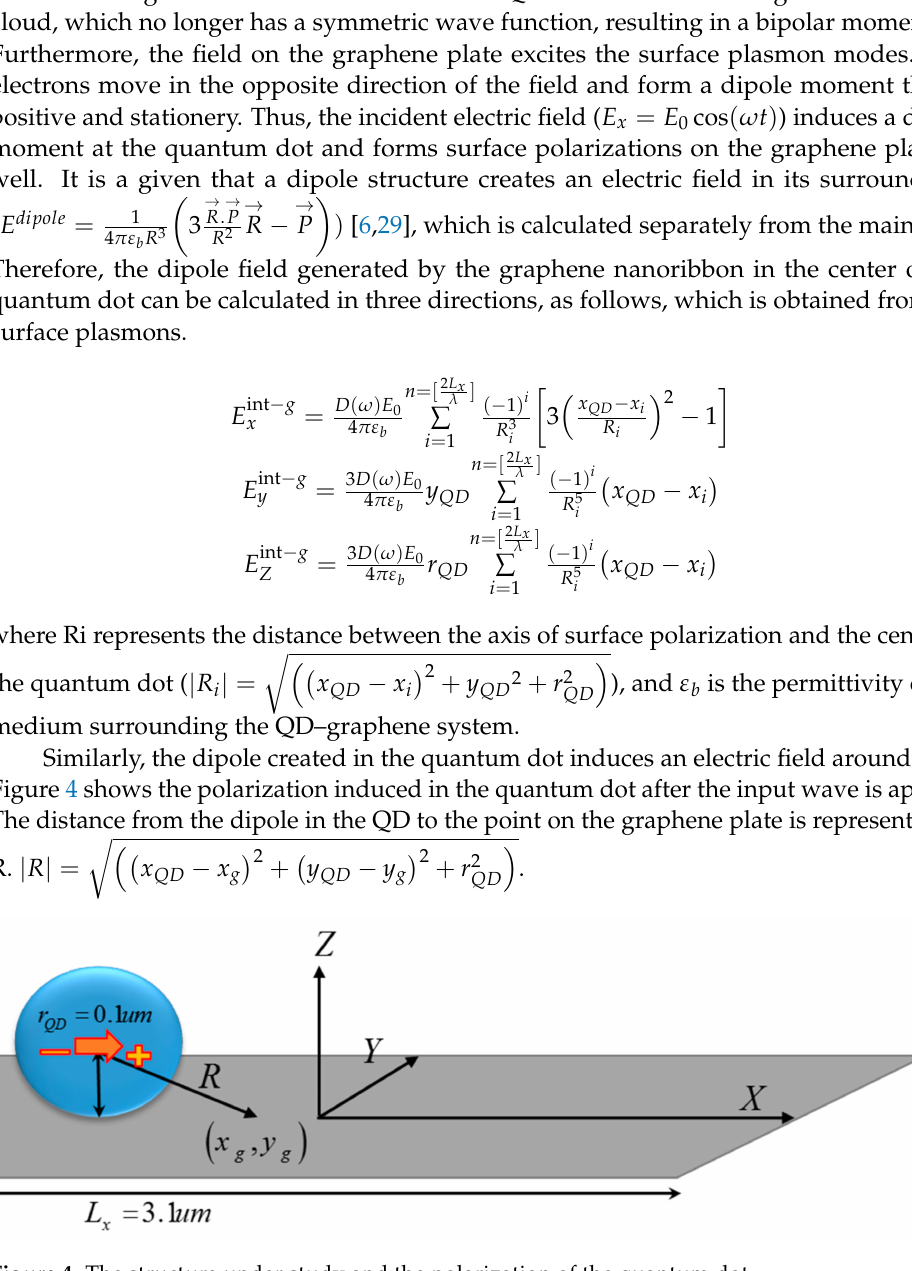
Figure 4. The structure under study and the polarization of the quantum